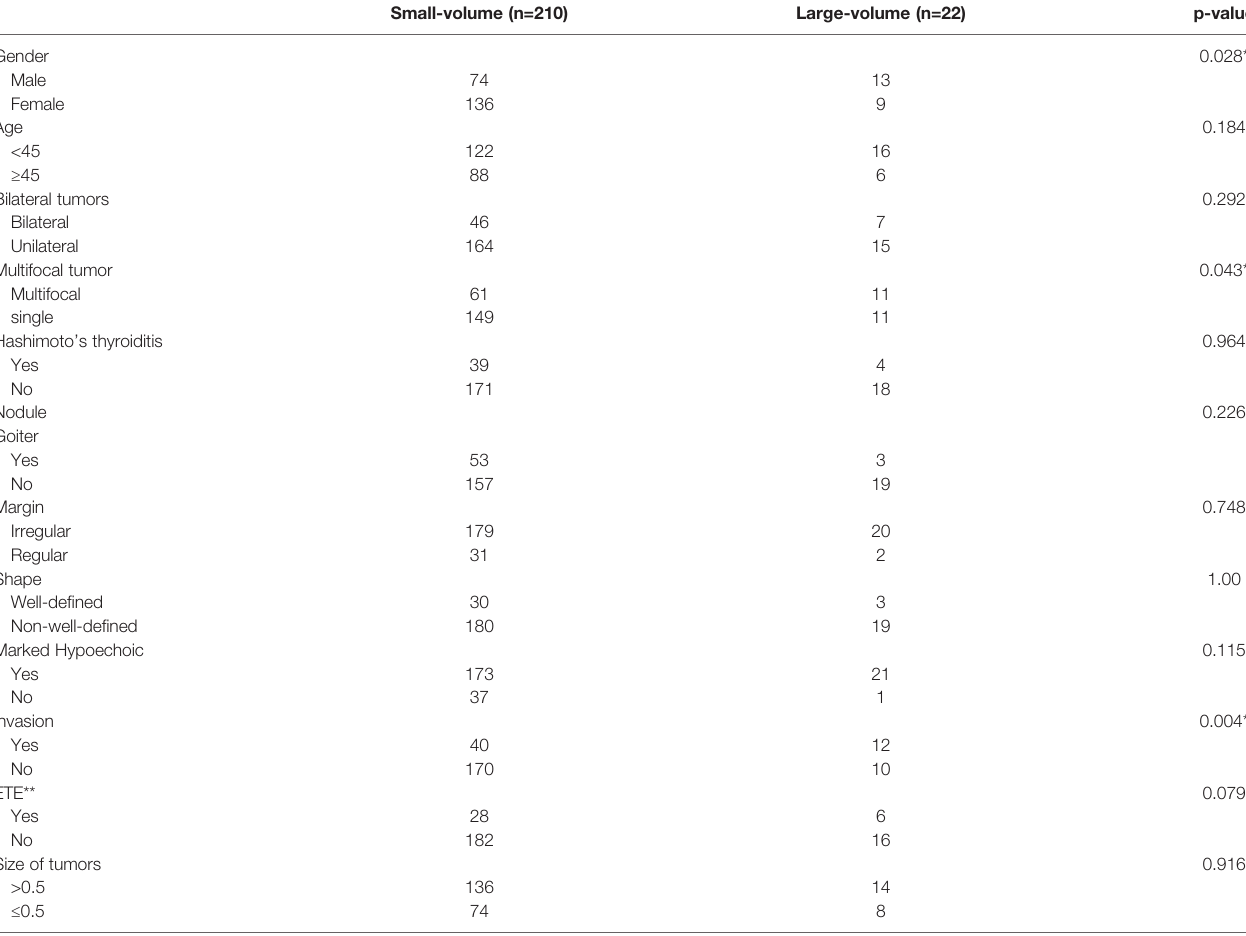
TABLE 3 | Clinicopathological characteristics and univariate analysis of PTMC patients (n=232).